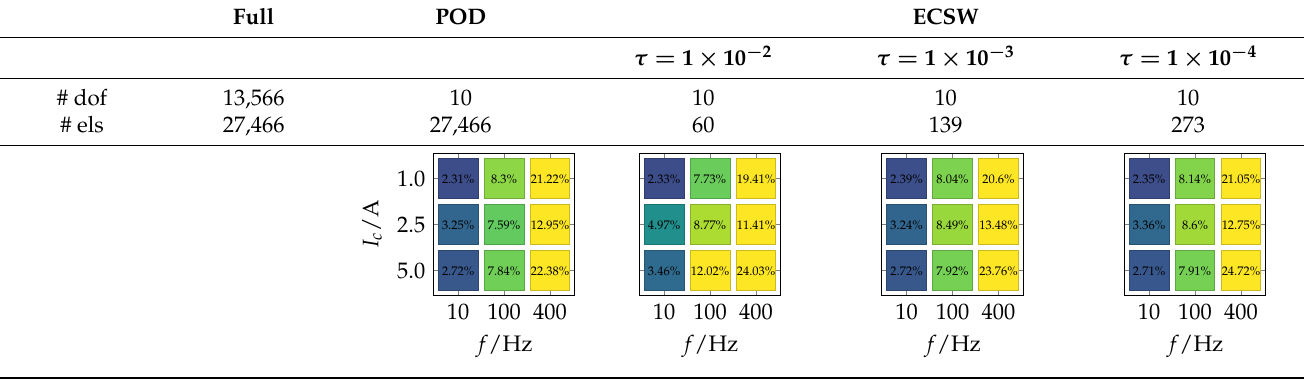
Table 4. Relative errors, always referred to in the full simulation reference, of the force for different parameters and excitations for each of the three hyper-reduction